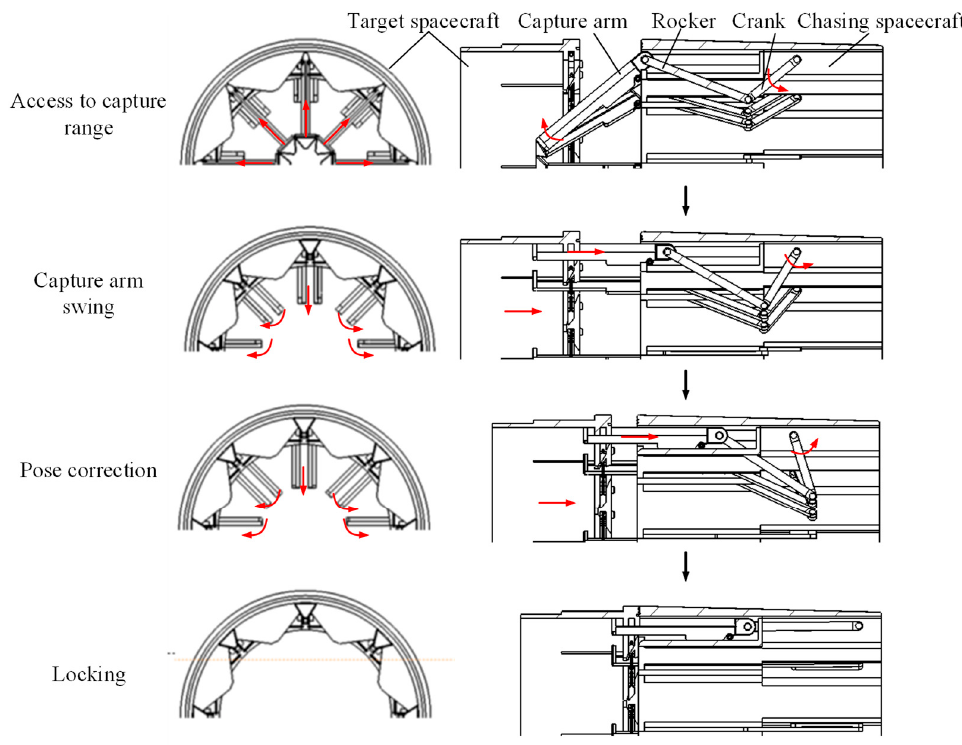
Figure 3. Capture principle and docking process.